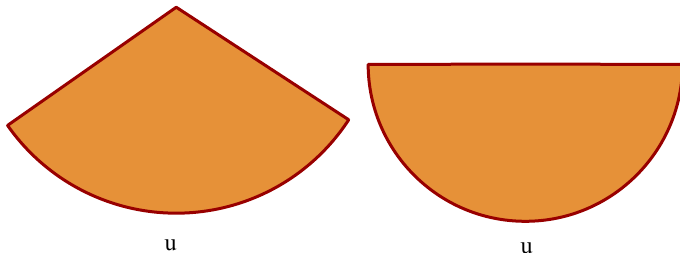
Figure 5 . Euclidean geometries with di(cid:11)erent cusps.